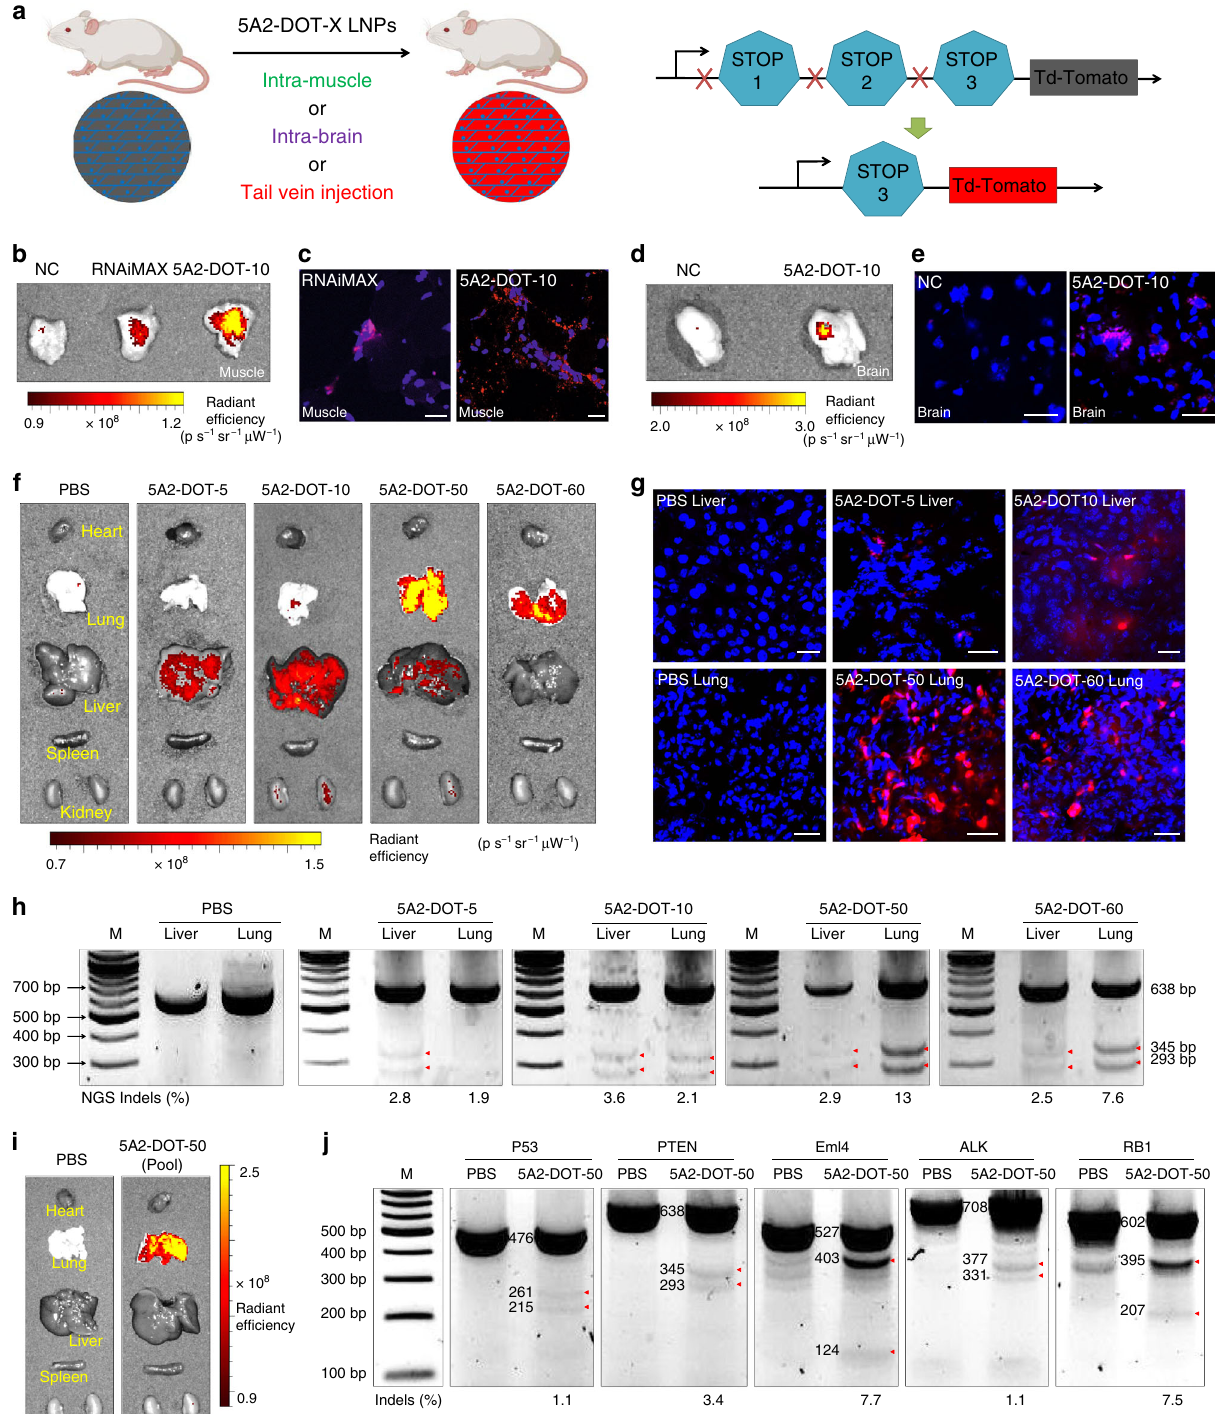
(CRISPR-guided gene editing) from liver to lung. 5A2-DOT-60 enabled mainly lung editing (Fig. 3f and Supplementary Fig. 7). These results indicate that deep tissue editing can be achieved in a tissue-speci fi c manner by adjusting the inner lipid component chemistry and molar ratios. Tissue-speci fi c editing was further con fi rmed by confocal imaging of tissue sections (Fig. 3g). We next examined editing of an endogenous target, PTEN , by systemically injecting LNPs encapsulating Cas9/sgPTEN RNPs into wild-type C57BL/6 mice. Clear T7EI cleavage bands were